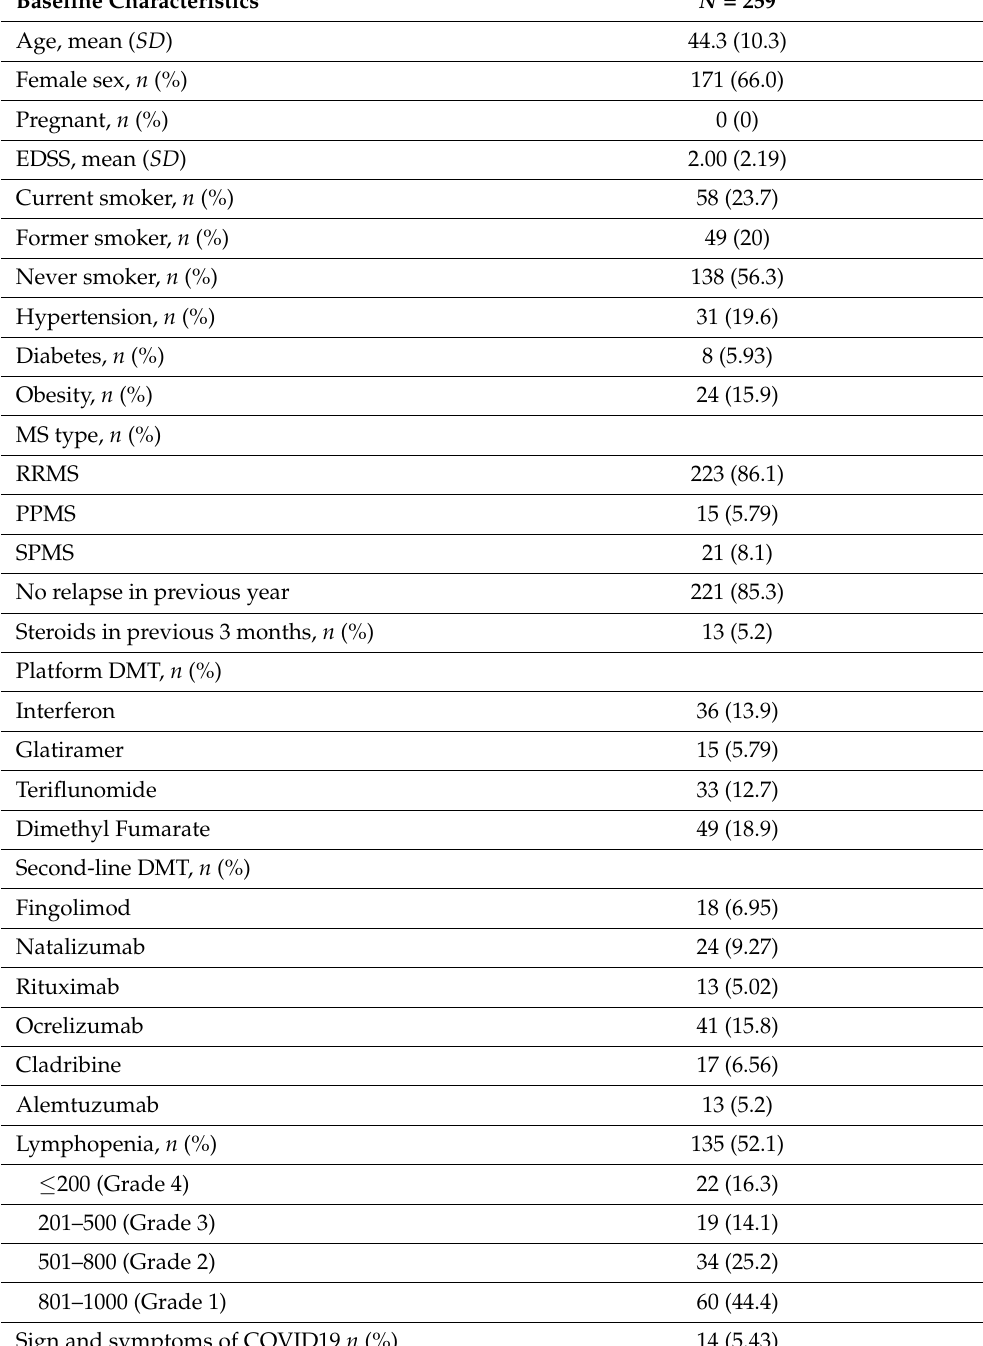
Table 1. Demographics, clinical characteristics, DMT, and COVID-19 immune